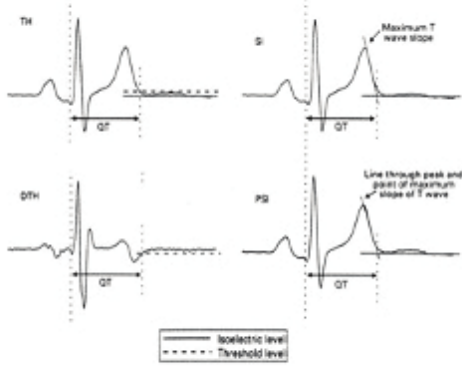
Figure 2 - Methods in Determining T wave Offset